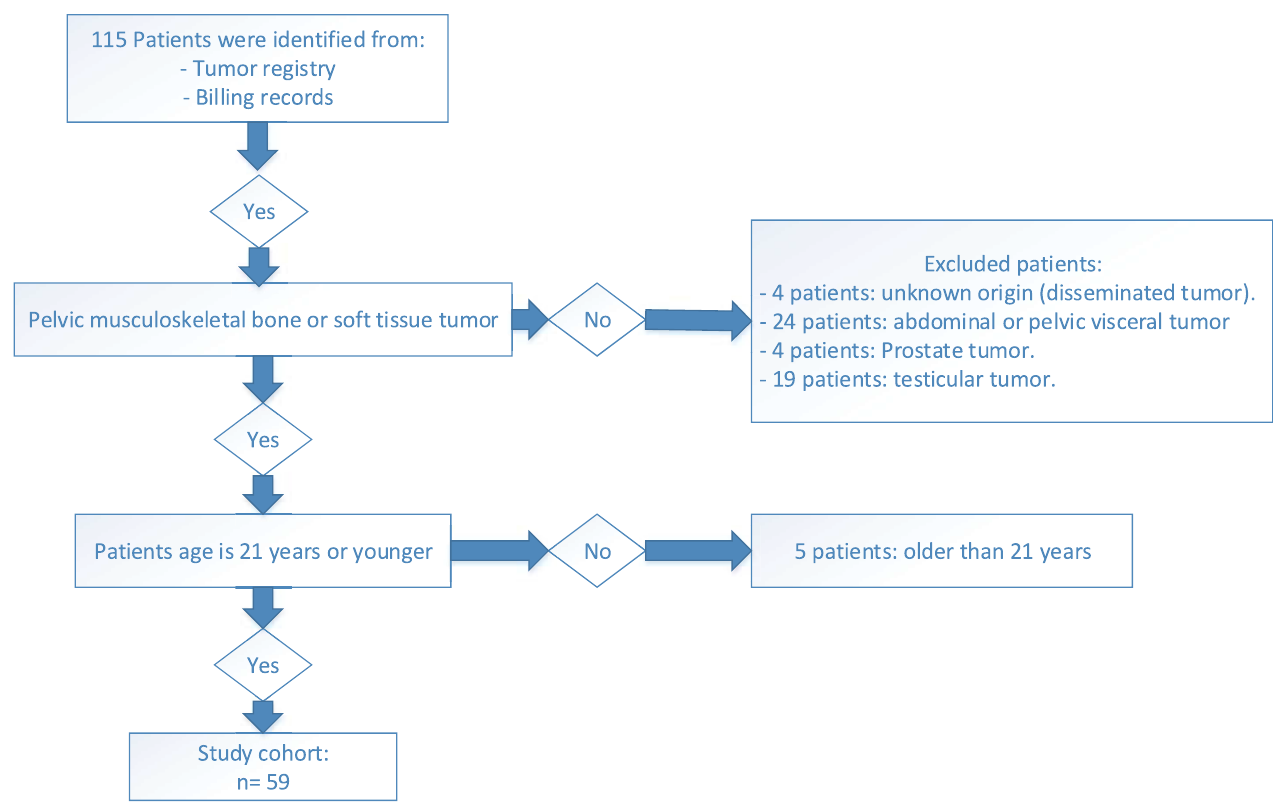
Figure 1. Schema illustrating the inclusion and exclusion